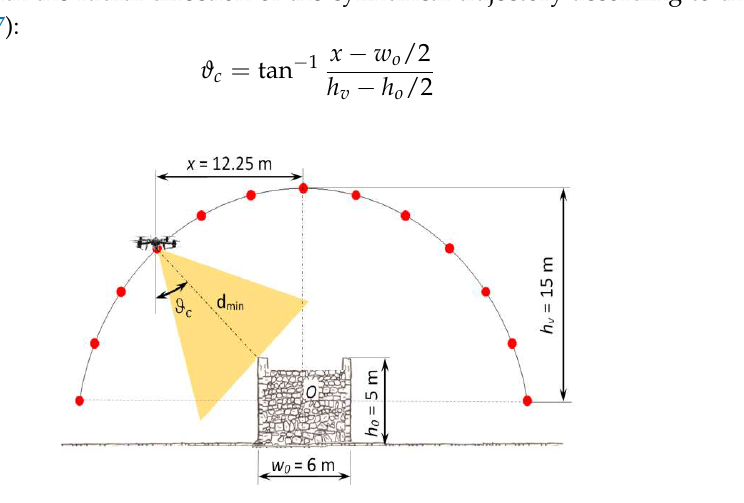
Figure 7. Gimbal rotation ϑ c in CG at ℎ (cid:3049) = 15 m.